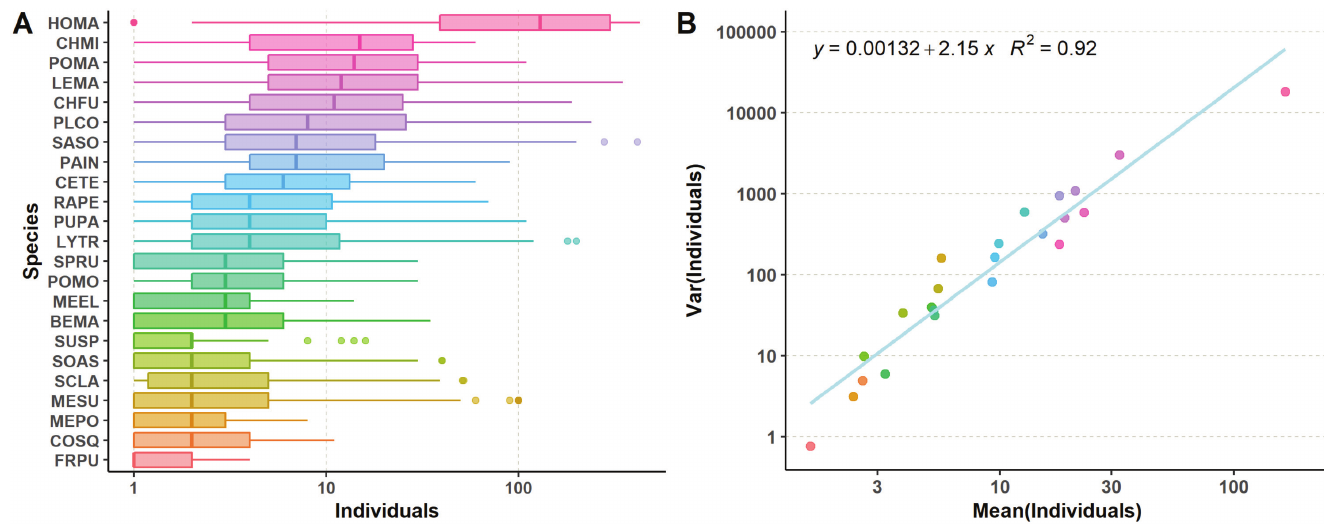
Fig 1. Species abundances. A: Boxplots of the distribution of individuals for each species, highlighting the median value. B: Scatter plot of the mean vs. variance for individuals by species, and regression line to check how they fit Taylor’s Law.